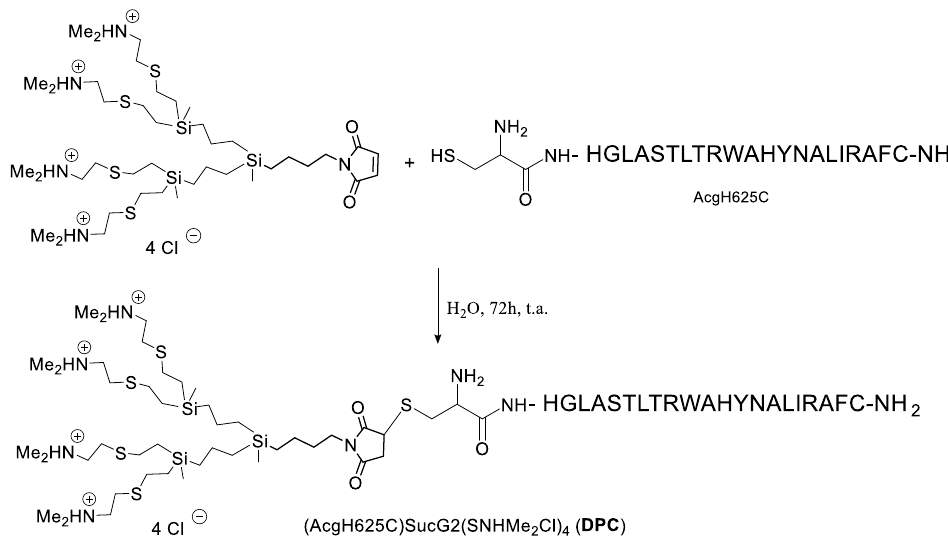
Scheme 1. Synthesis of carbosilane dendron – peptide